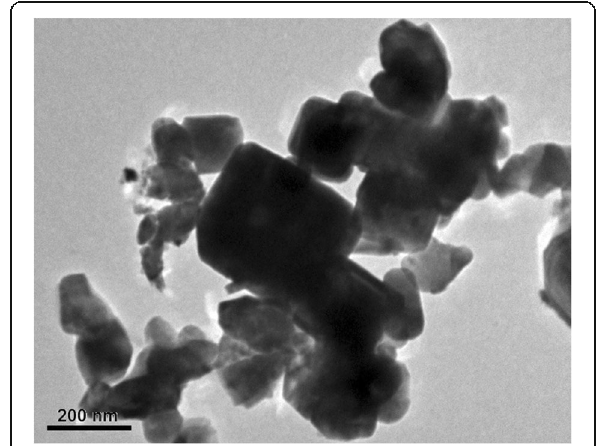
Fig. 4 TEM image of the KTaO 3 nanoparticles